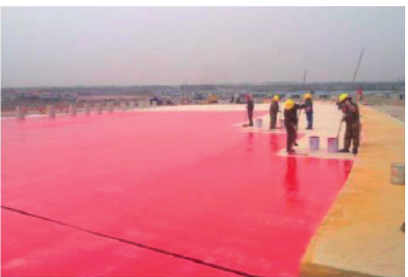
Figure 4: Application of MMA waterproof adhesive layer on bridge deck